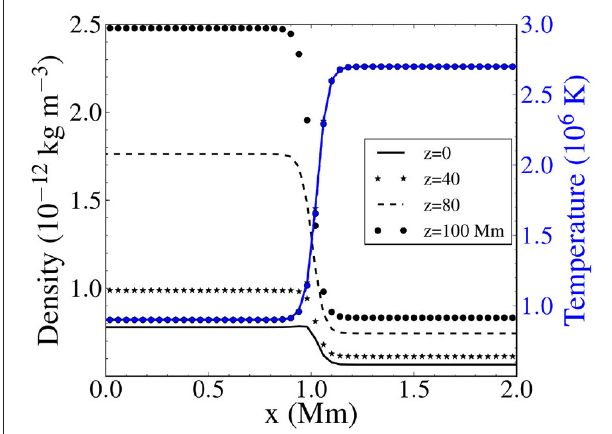
FIGURE 1 | Radial profile of the initial density (with black) and temperature (with blue) for our gravitationally stratified, cylindrical flux tubes at different heights, right before the introduction of the driver. The apex is located at z = 0 and the footpoint at z = 100 Mm. x = 0 is the center of the loop at t =